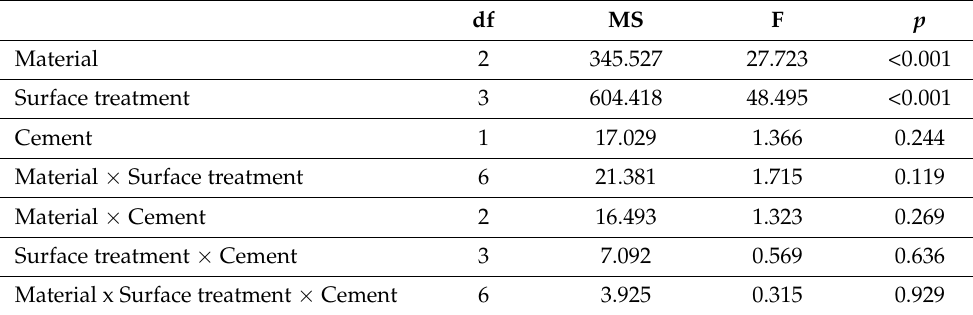
Table 3. Means and standard deviations of surface roughness values for control and treated groups.